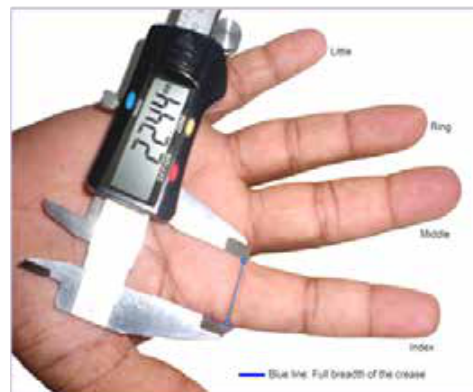
Table II: Correlation between index finger length